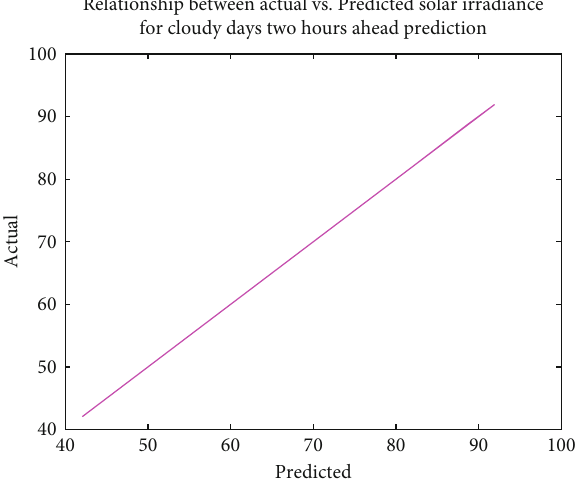
Figure 27: Relationship between actual vs. predicted solar irradiance for cloudy day two-hour-ahead prediction.